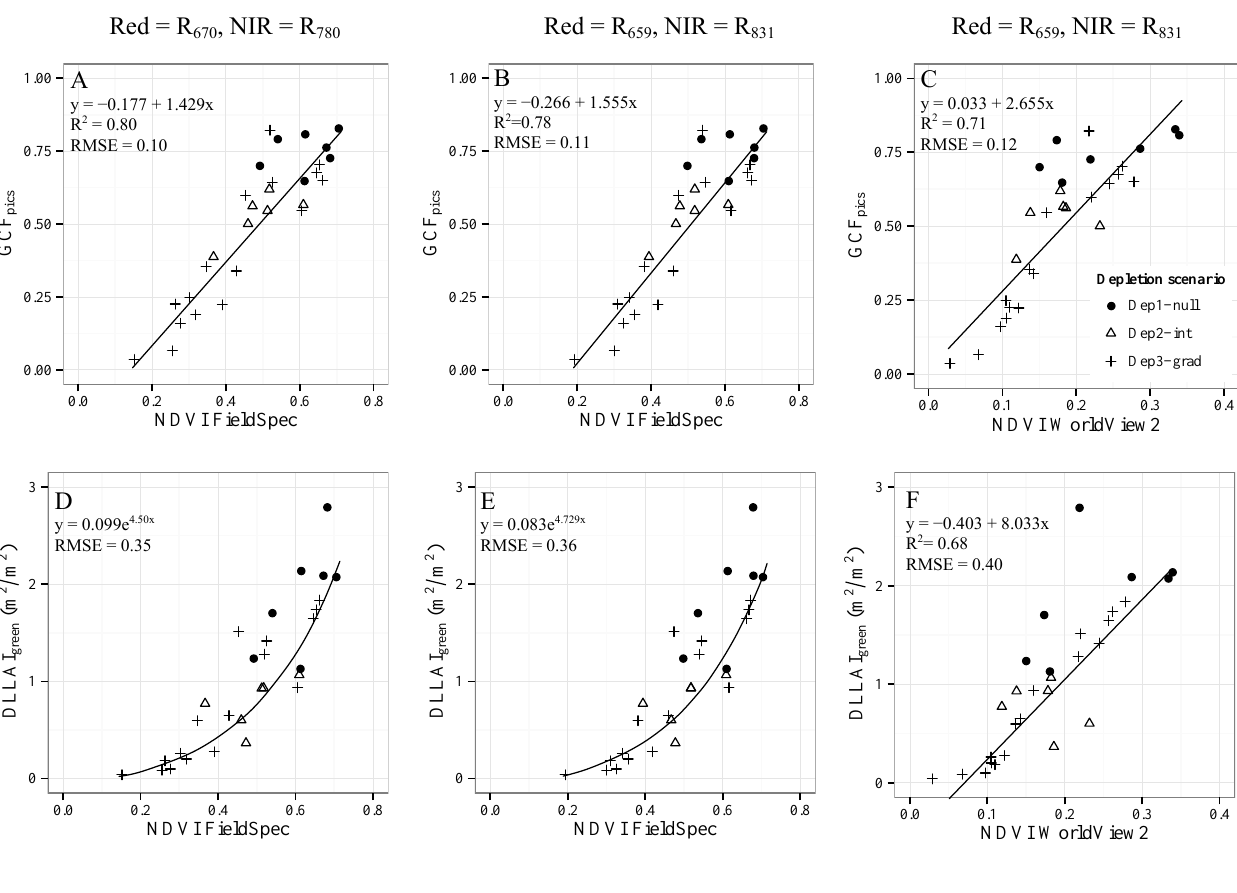
Figure 9. Relationships between NDVI vs. GCF for 32 Tamarugo trees. NDVI was calculated using specific FieldSpec bands (first two columns) and the WorldView2 broad bands (third